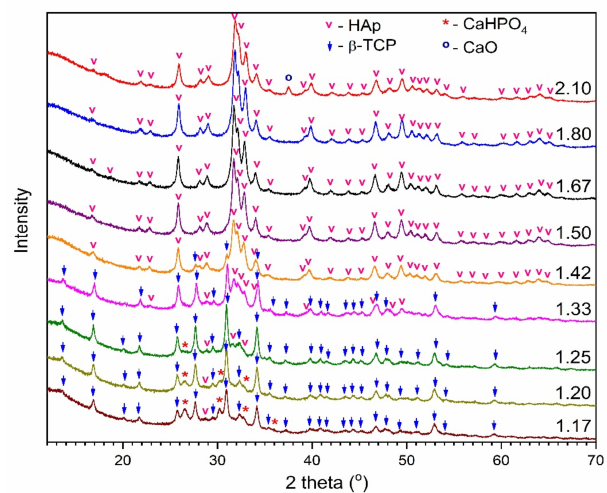
Figure 1. PXRD patterns of mechanochemically synthesized samples with different Ca/P